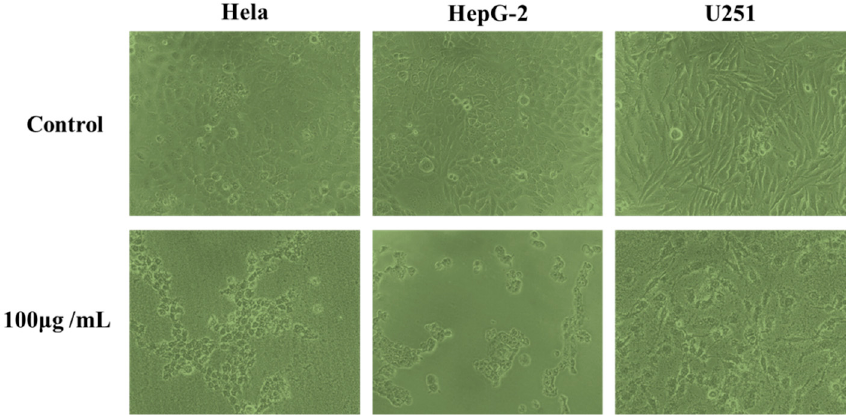
Figure 6. Morphological changes of Hela, HepG-2 and U251 cells treated for 24 h with 100 μ g/mL of phenolic extracts of T. quadrispinosa stem obtained by UAEE.